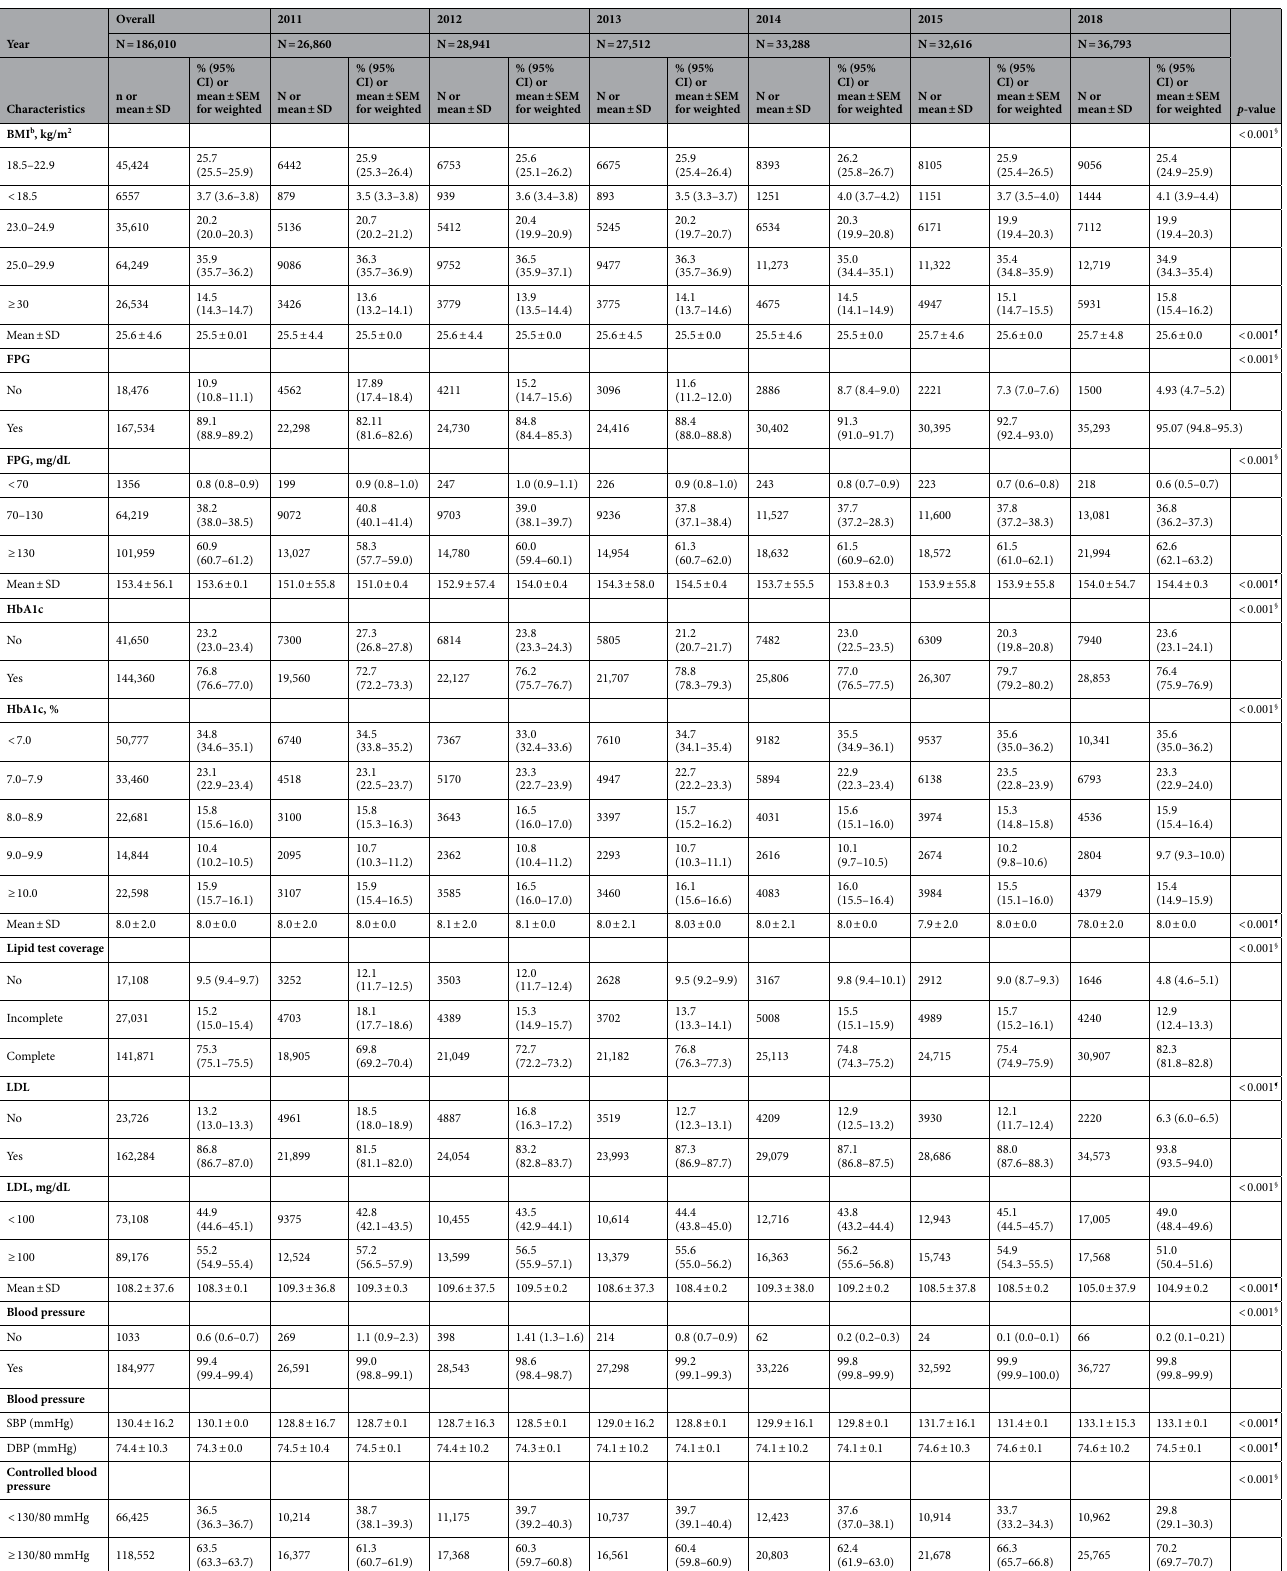
Table 2. Clinical laboratory test results of the enrolled patients with type 2 diabetes from 2011 to 2015 and 2018. BMI: body mass index; FPG: fasting plasma glucose; HbA1c: hemoglobinA1c; LDL: low density lipoprotein cholesterol; SBP: systolic blood pressure; DBP: diastolic blood pressure. a There were 7636 missing values for BMI, 1033 missing values for blood pressure. b BMI was calculated as weight in kilograms divided by height in meters squared. §